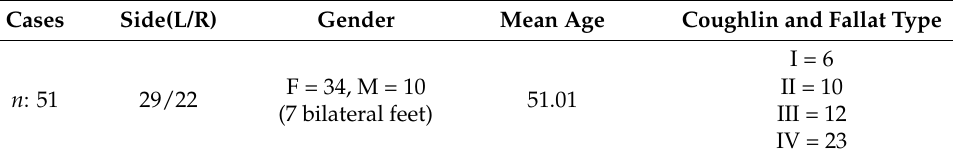
Table 1. Patient